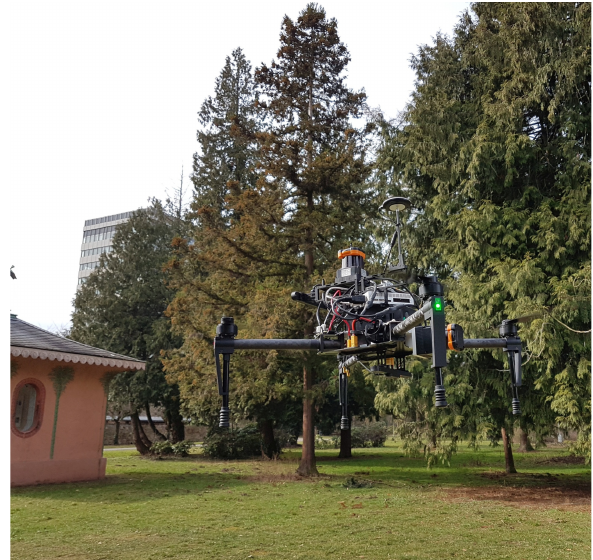
Figure 2. Data acquisition with the proposed unmanned aerial system for UAV-borne laser scanning with horizontally and verti- cally oriented line